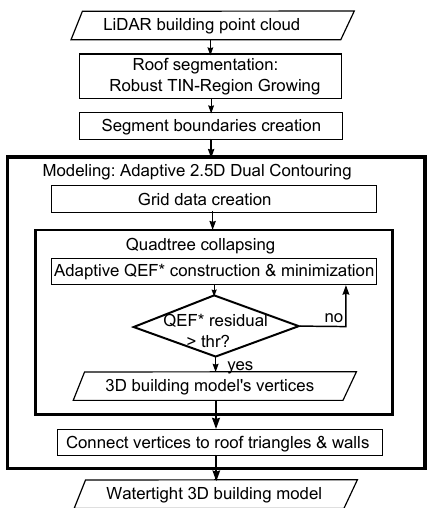
Figure 1. Overview of the proposed workflow for 3D building model reconstruction from LiDAR point clouds. QEF abbrevia- tion stands for Quadratic Error Function (Eq.